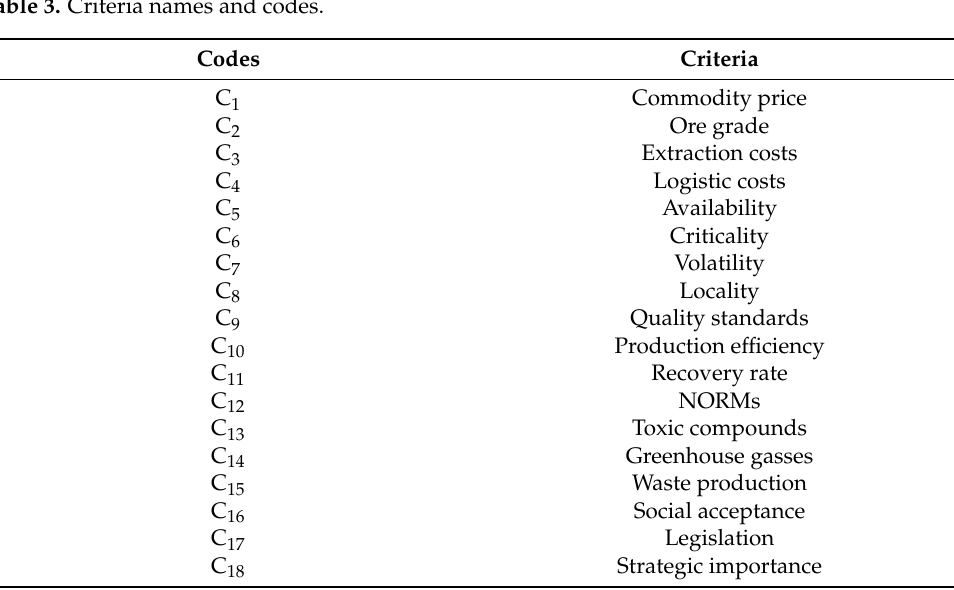
Table 3. Criteria names and codes.